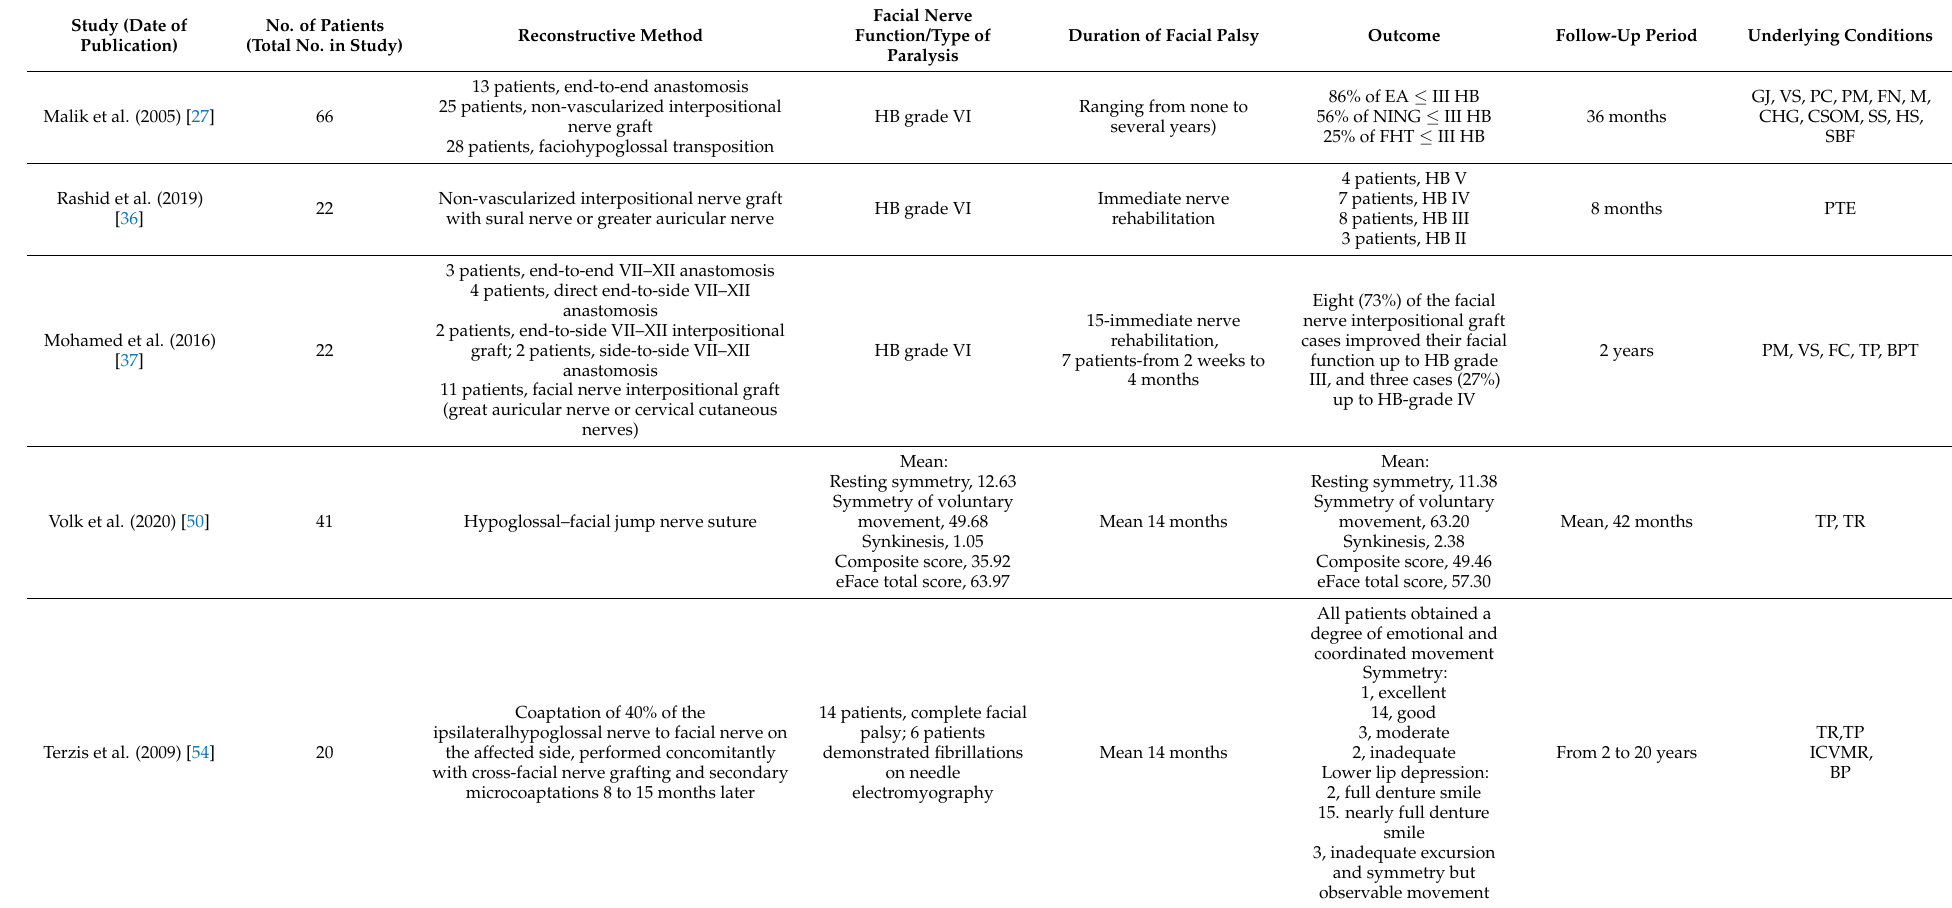
Table 1. Outcomes of the described reconstructive methods of the facial nerve, the number of patients included in the given study, the underlying cause of facial paralysis, the chosen reconstructive method, and the type of facial paralysis and its duration, as well as the follow-up